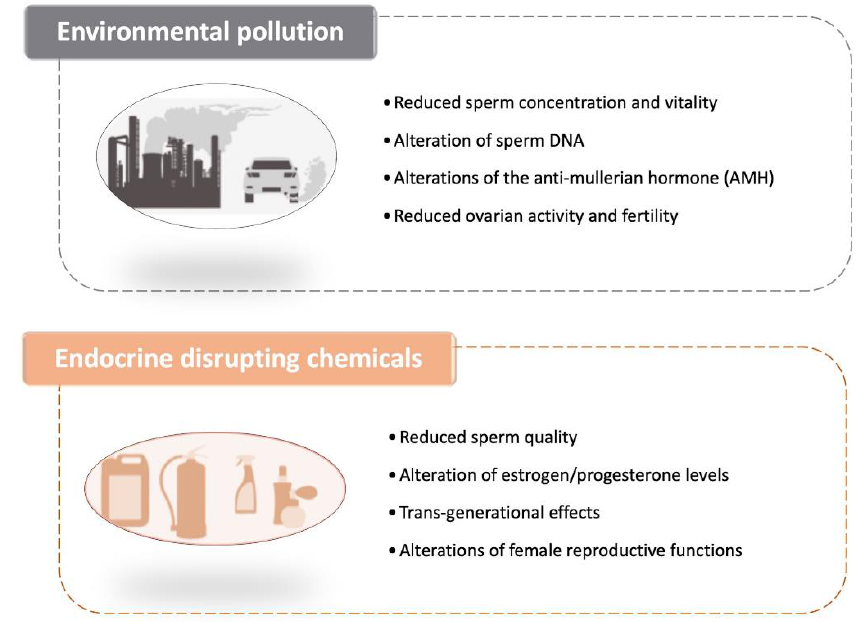
Figure 2. Effects of environmental pollution and endocrine disrupting chemicals on fertility [117–